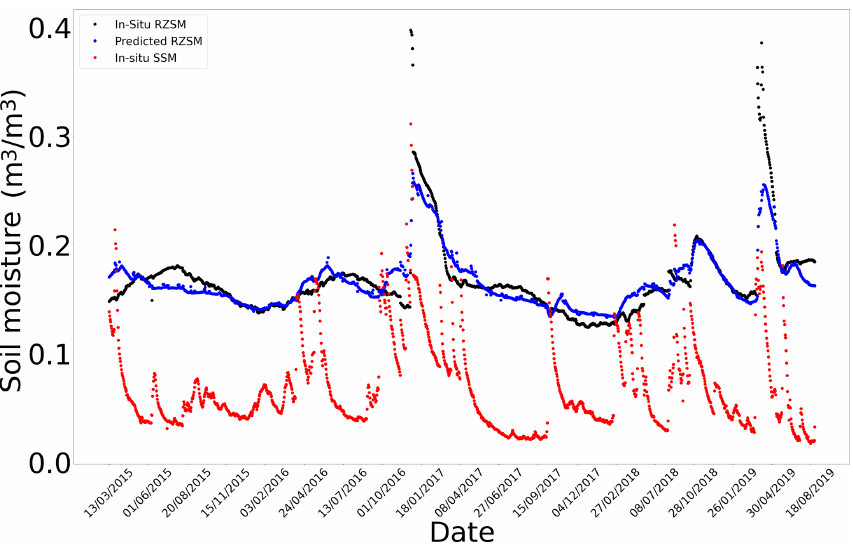
Figure G2. In situ SSM, in situ RZSM, and predicted RZSM series at station Barrage-162 (Tunisia) with model ANN_SSM_NDVI_EVAP-